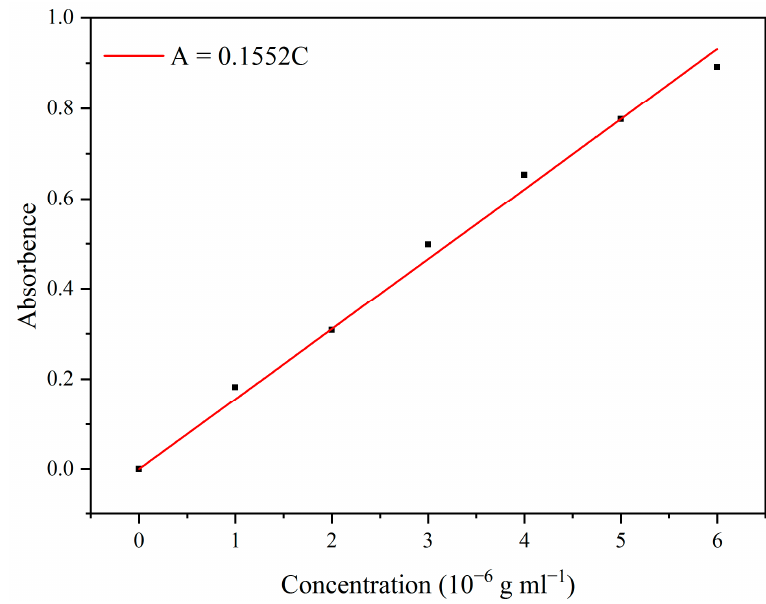
Figure 8. Methylene blue standard curve.